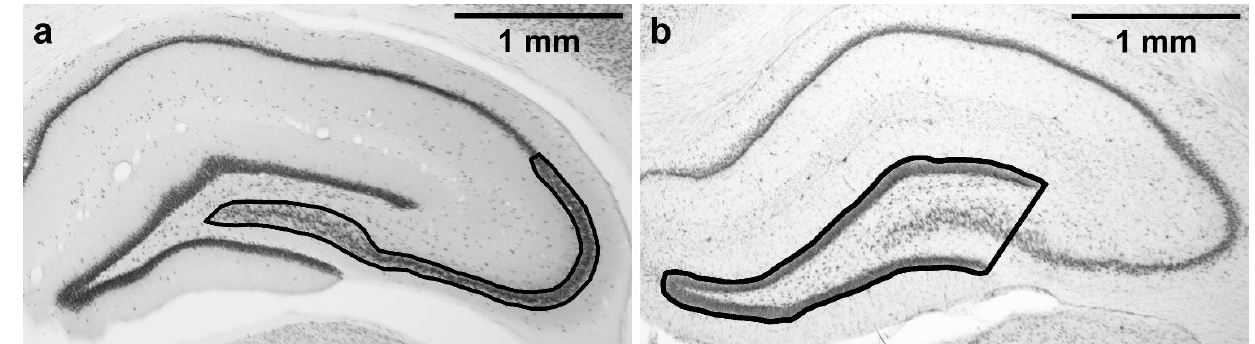
Figure 2. Regions of interest tracing. ( a ) CA2/3 subfield, where the stereological counting was performed; ( b ) area of dentate gyrus. Magnification: 2×. Microphotographs in Figure 2 were acquired using a microscope (Olympus BX53, 2×/0.08 objective lens) connected to a camera (Olympus DP74 for the Olympus BX53 microscope, and Zeiss AxioCam MRm for the Zeiss microscope) and acquisition system in brightfield illumination in grayscale camera mode.